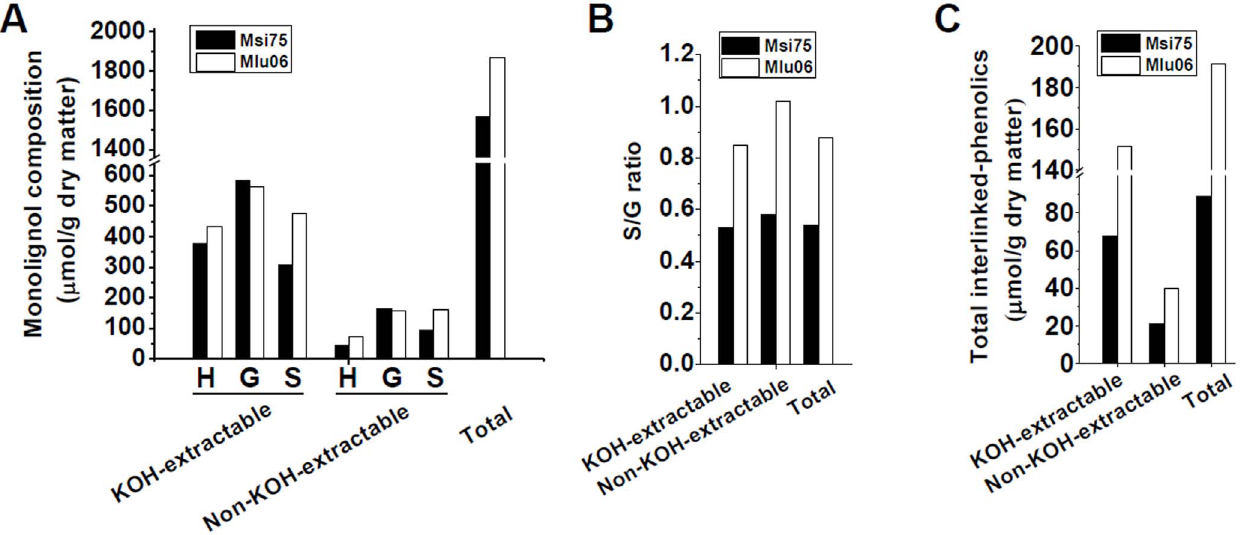
Figure 6. Analysis of monolignol and interlinked-phenolics compositions in the representative Miscanthus samples. (A) Monolignol composition; (B) S/G ratio; (C) Total interlinked-phenolics.